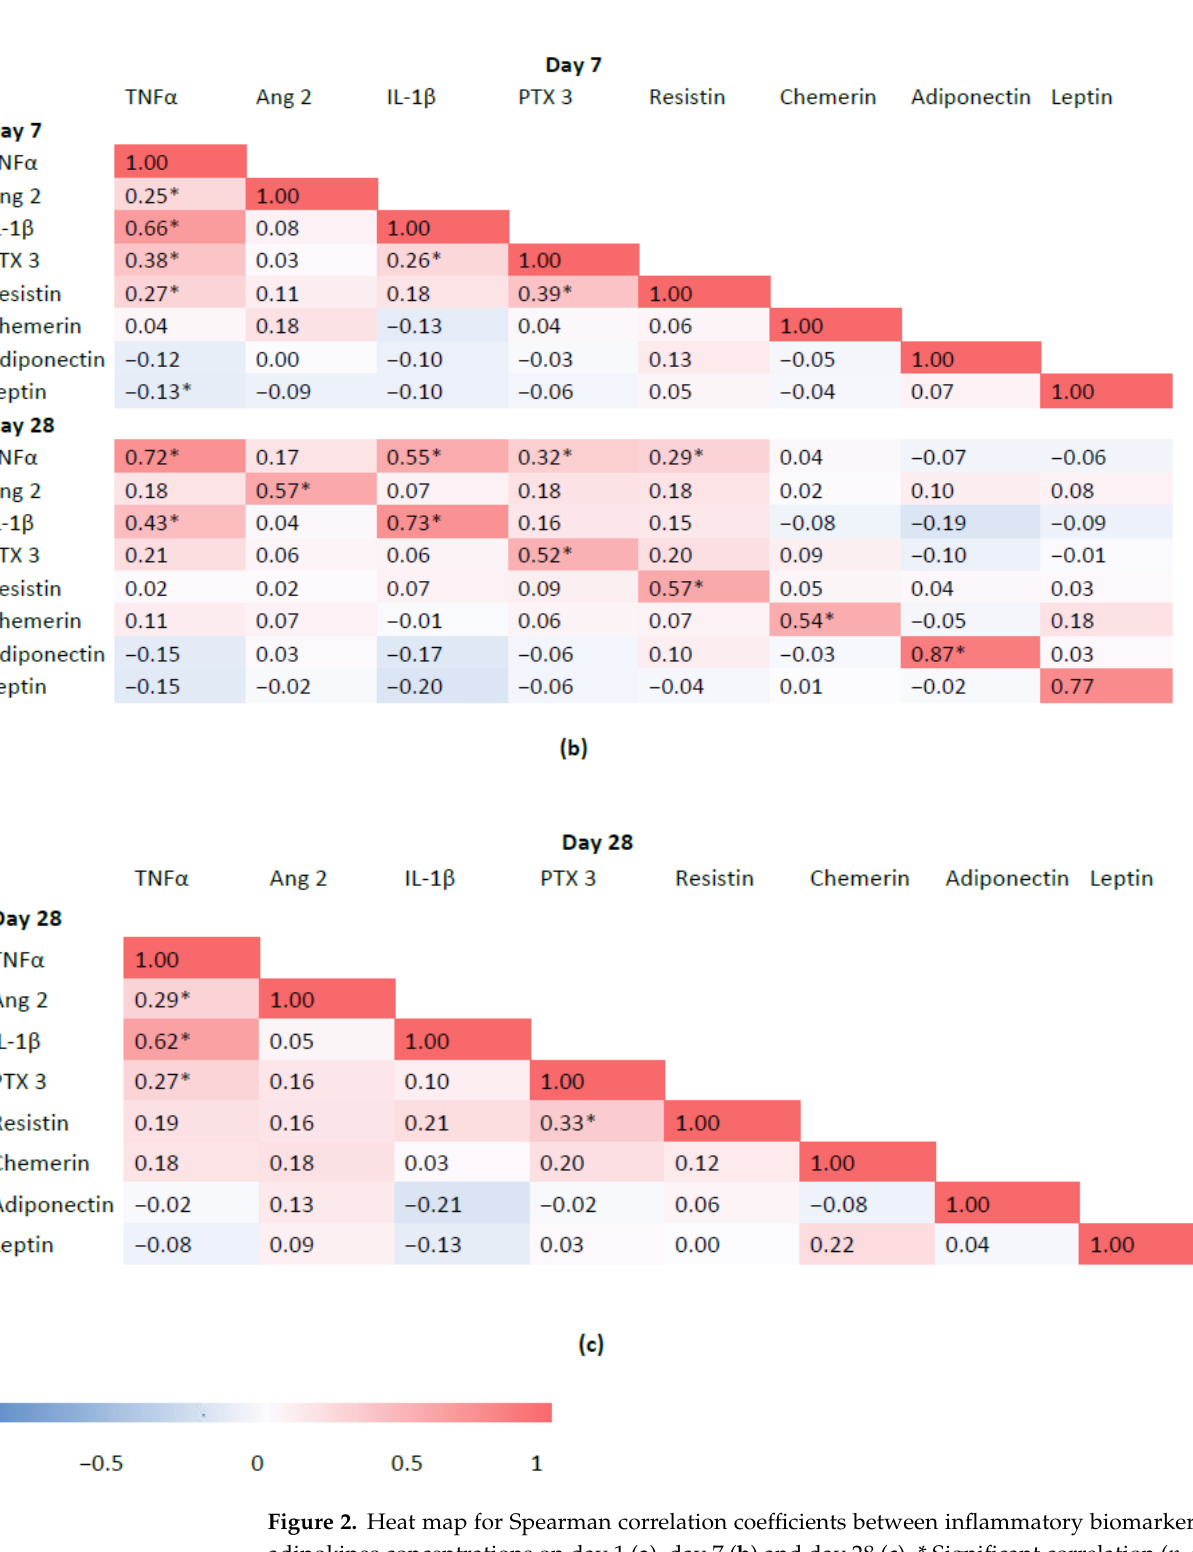
Figure 2. Heat map for Spearman correlation coefficients between inflammatory biomarkers and adipokines concentrations on day 1 ( a ), day 7 ( b ) and day 28 ( c ). * Significant correlation ( p < 0.05) after Bonferroni correction for multiple comparisons. CRP, C-reactive protein; TNF α , tumor necrosis factor alfa; Ang 2, angiopoietin 2; Il1 β , interleukin 1 beta; PTX 3, pentraxin